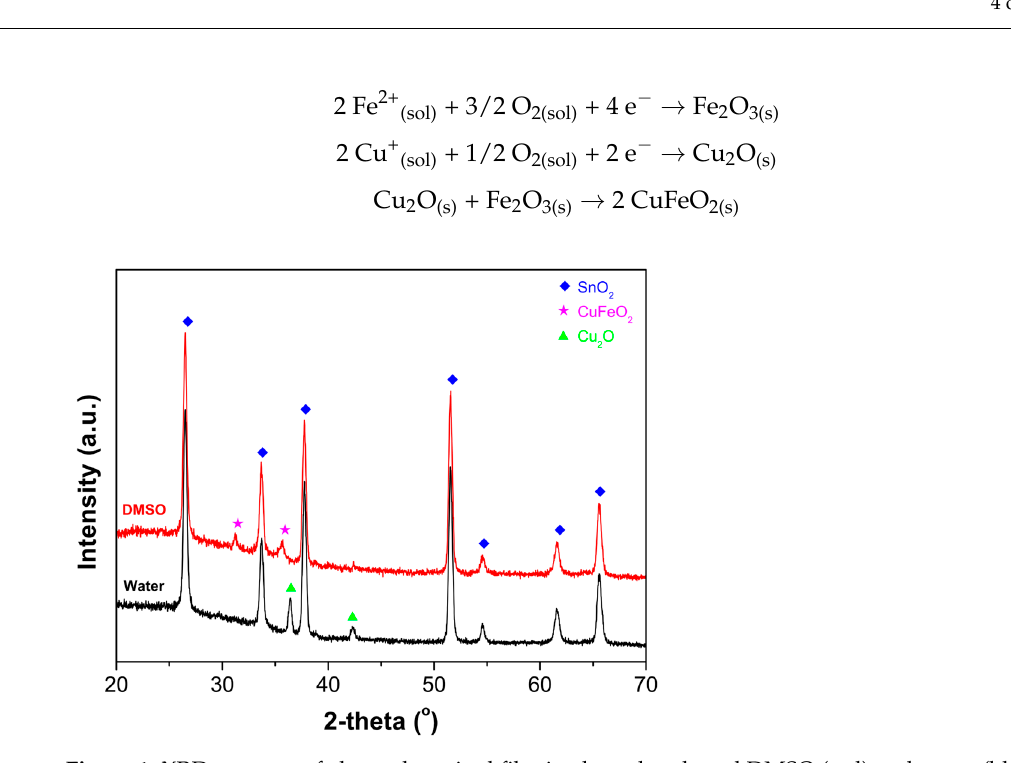
Figure 1. XRD patterns of electrodeposited film in electrolyte-based DMSO (red) and water (black) solvents. Electrodeposition was carried out by applying a current density of − 0.2 mA cm − 2 for 60 min and the films were annealed at 650 °C for 1 h under N 2 gas flow after electrodeposition.